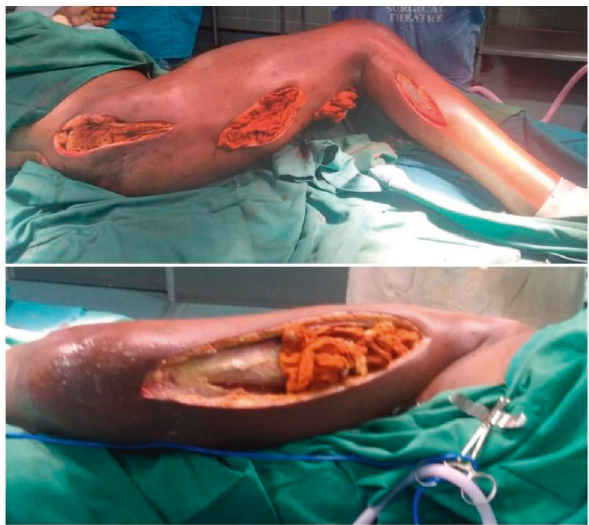
Figure 3: Initial debridement-offensive abscesses in the anterior and lateral aspects of the right thigh, right hip, and right lower